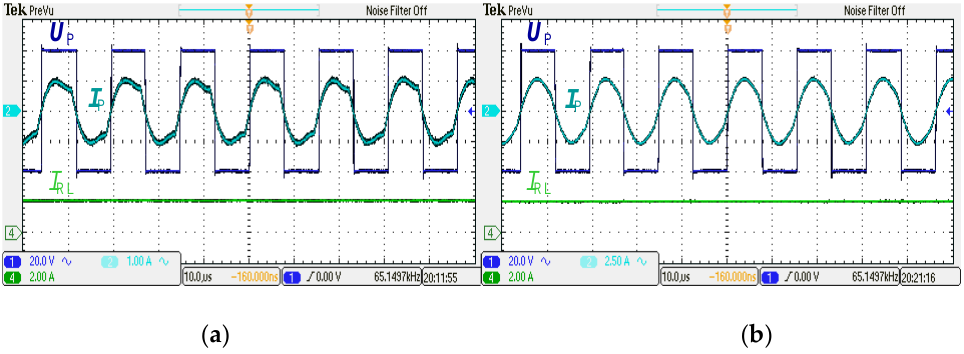
Figure 10. Experimental waveforms of U P , I P and I RL in CC charging mode. ( a ) R L = 5Ω ( b ) R L = 15 Ω.